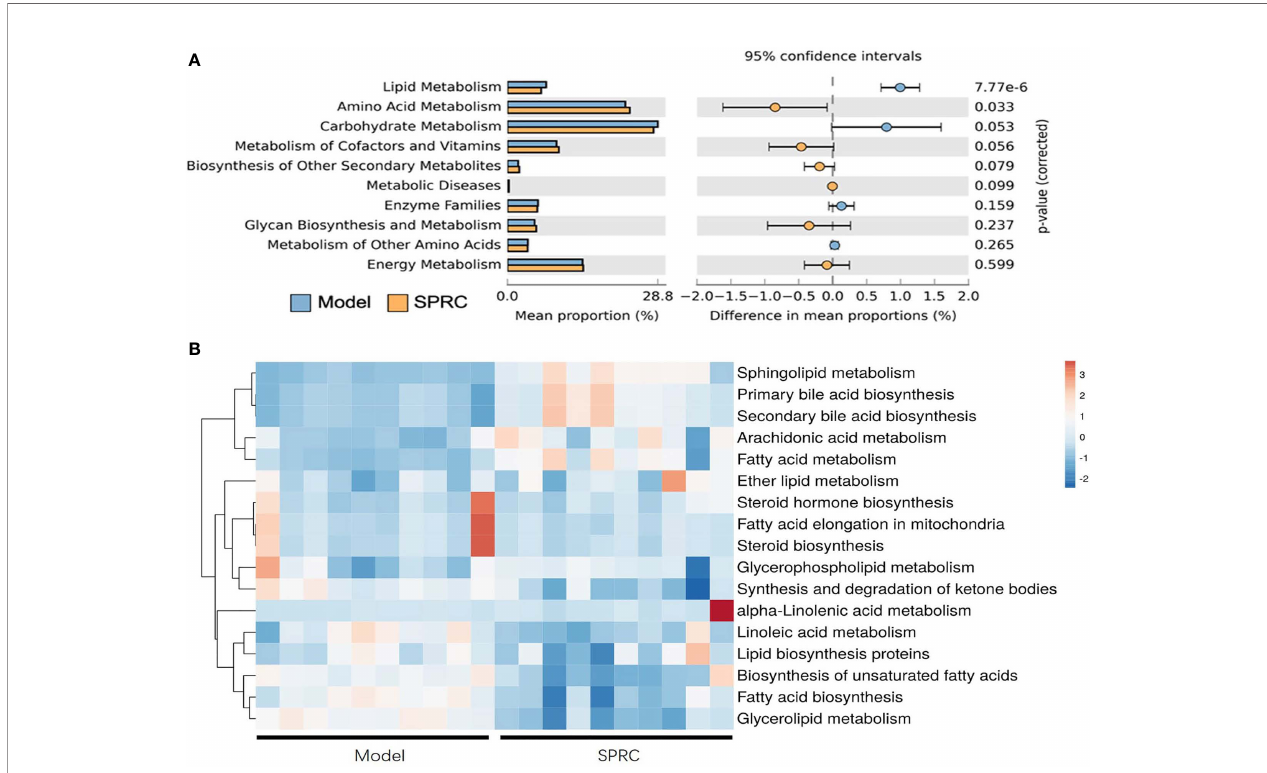
FIGURE 6 | Inferred gut microbiome functions from the PICRUSt analysis of 16S rRNA gene sequences between the Model and SPRC groups on the 28 th day. Changes in the functions at KEGG level-2 (A) and level-3 (B) showed that microbial functions were altered by the SPRC treatment. Colors in the heat map indicate the relative abundance of metabolite levels. Red indicates metabolites that were upregulated, and blue indicates metabolites that were